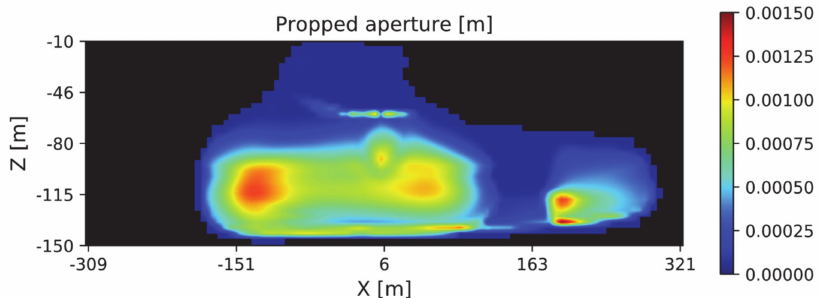
Figure 8. Propped aperture for the 3rd of the 5 hydraulic fractures shown in Figure